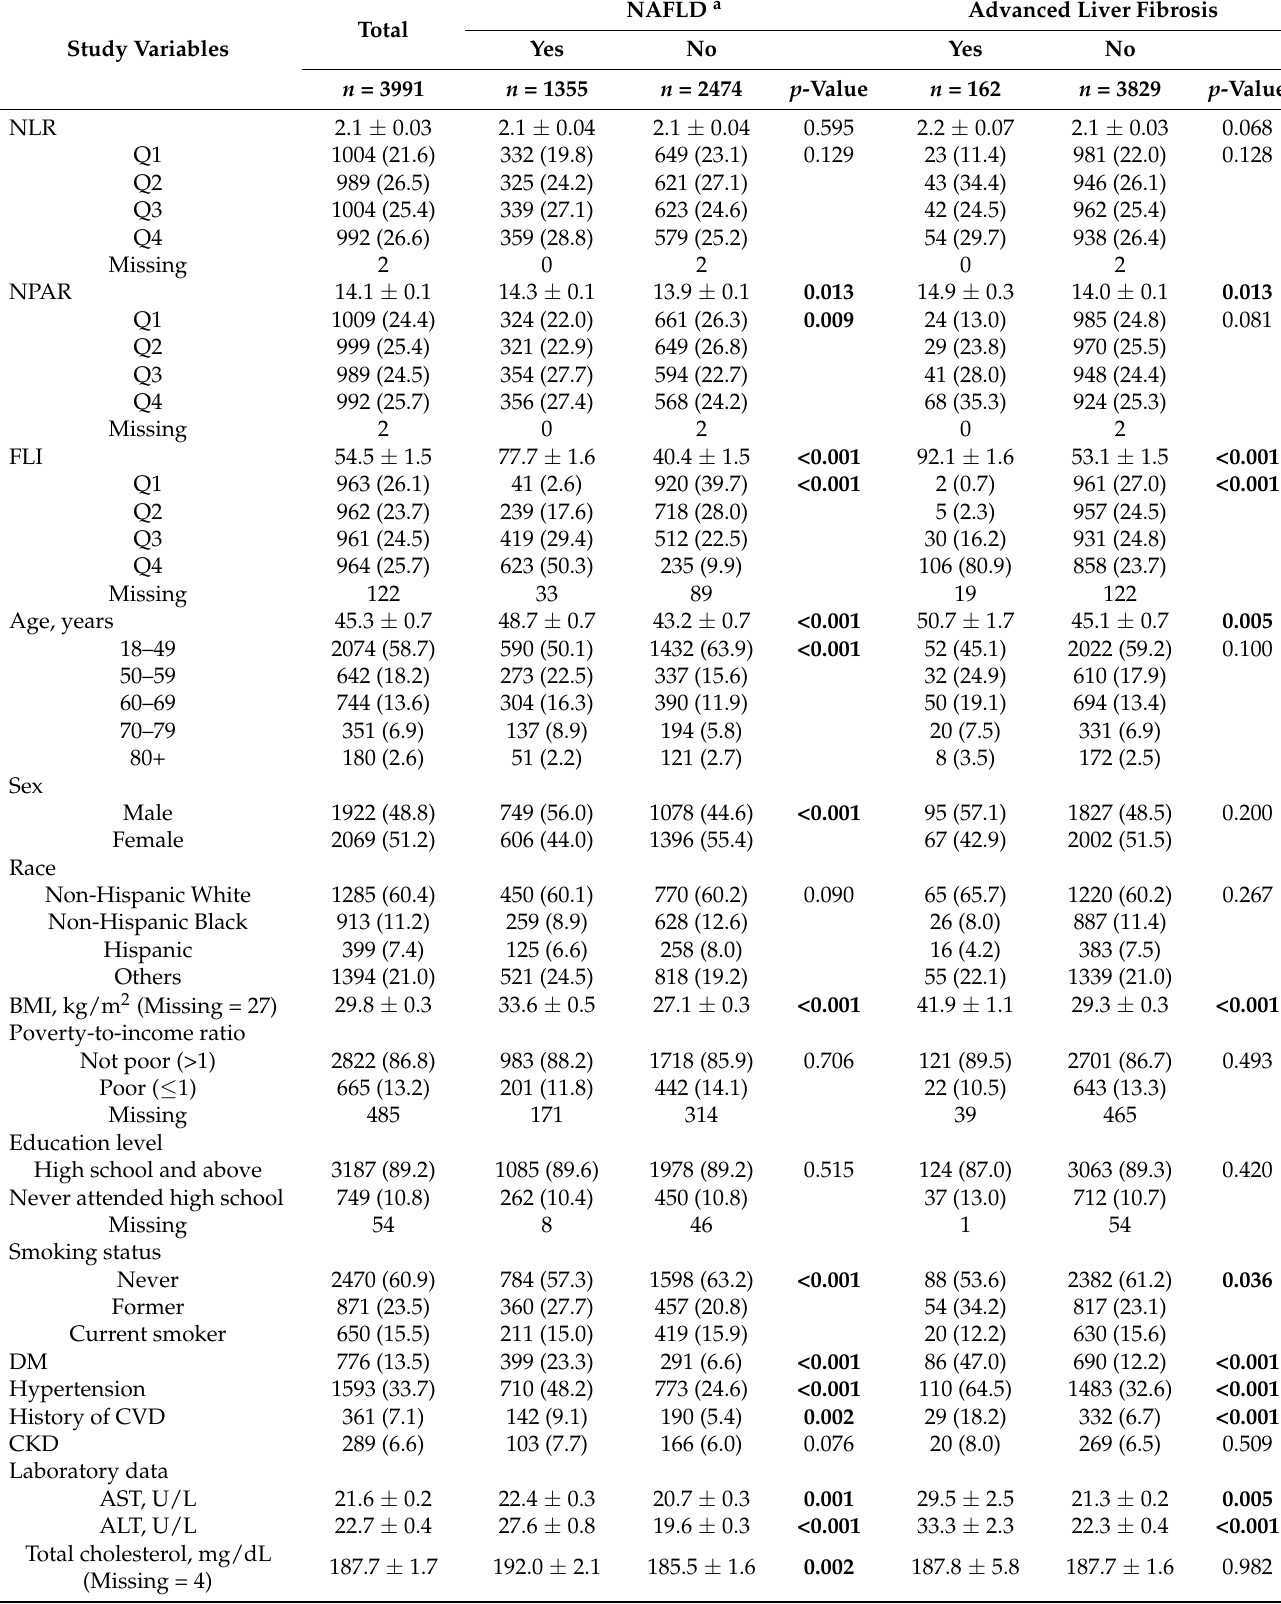
Table 1. Characteristics of the study